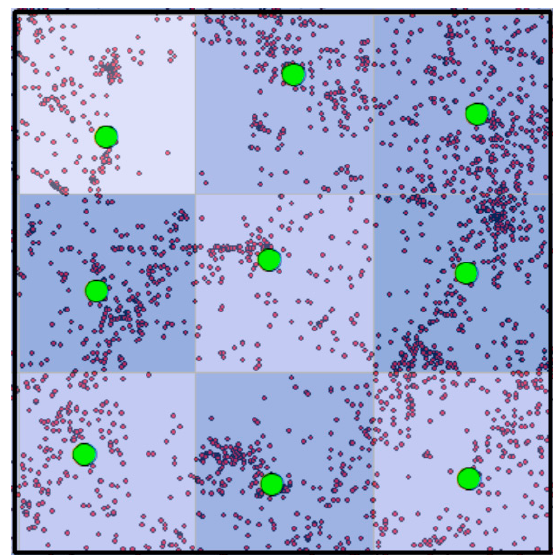
Figure 3. Photo locations are depicted in red dots, and photo centroids (POIs), depicted in green, are computed and saved in the cell data structure.